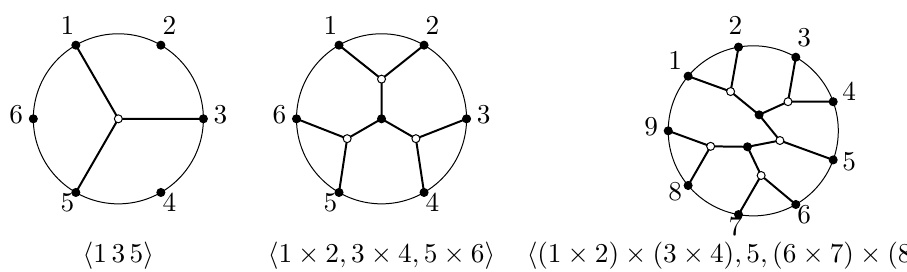
Figure 3. Examples of sl 3 webs and their corresponding